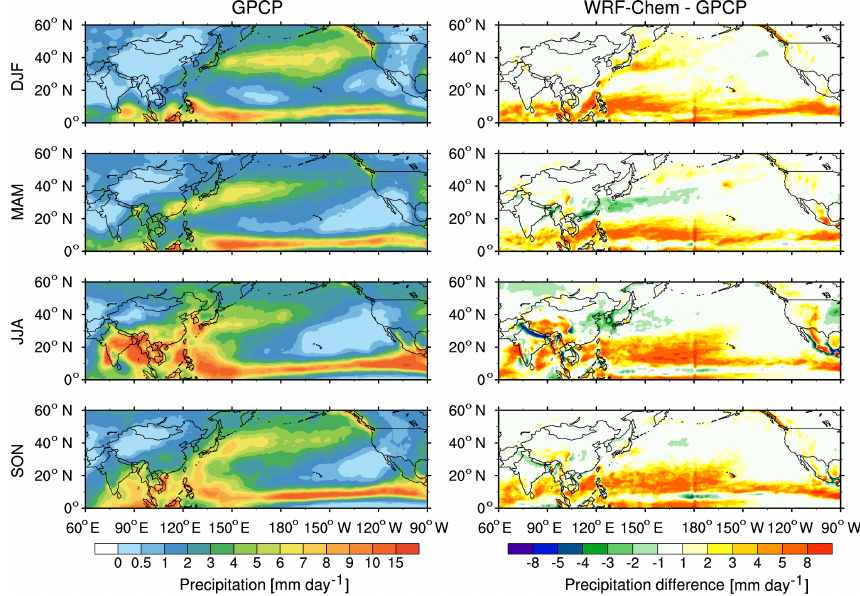
Figure 3. Spatial distributions of seasonal-averaged precipitation from the GPCP observation and the difference between observation and simulation for the period